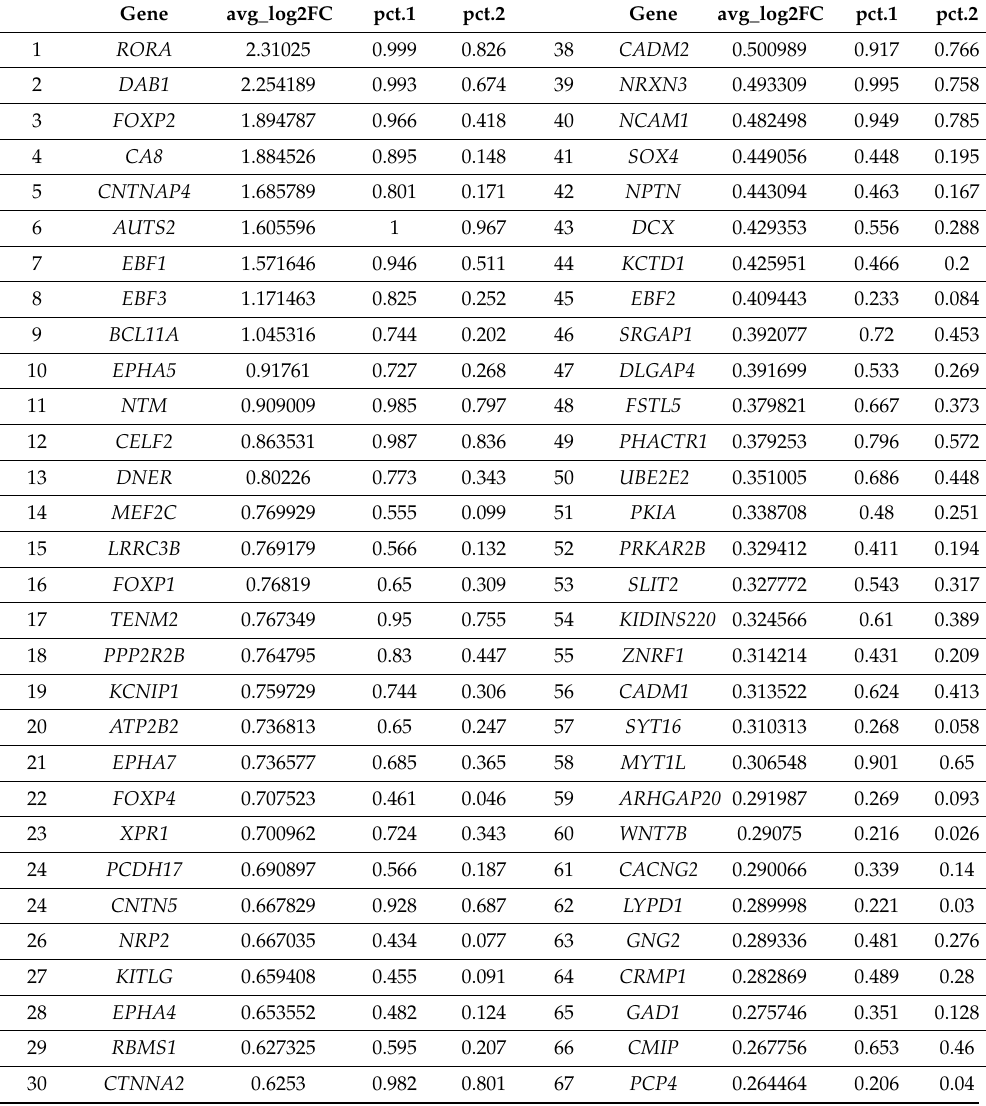
Table 2. Common Purkinje cell marker genes across mouse and human identified from single-cell sequencing. Differentially upregulated genes in the Purkinje cell cluster were identified in human [26] and mouse [25] transcriptomic datasets using the Seurat FindMarkers function. Human homologues of the mouse Purkinje cell gene set were found using Ensembl BioMart (Ensembl release 107—July 2022 [37]). A total of 73 genes were found in common in Purkinje cells across the two datasets. These are listed in order of average log2(fold change) in the human Purkinje cell cluster. A total of 215 genes were only found as Purkinje cell markers in the human dataset, and 486 only in the mouse dataset. However, many of these showed high expression in Purkinje cells across both species, though not reaching significance. avg_log2FC, Average log2(fold change) in expression in the Purkinje cell cluster compared to all other cells in the dataset; pct.1, Proportion of Purkinje cells expressing gene; pct.2, Proportion of cells expressing gene in the second-highest cluster. pct.1